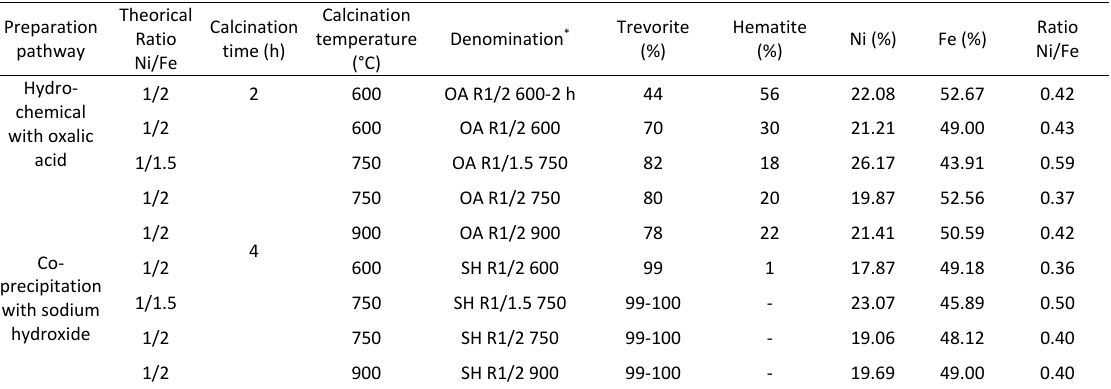
Table 1: X-ray diffraction and x-ray fluorescence analysis of prepared ferrites Preparation pathway